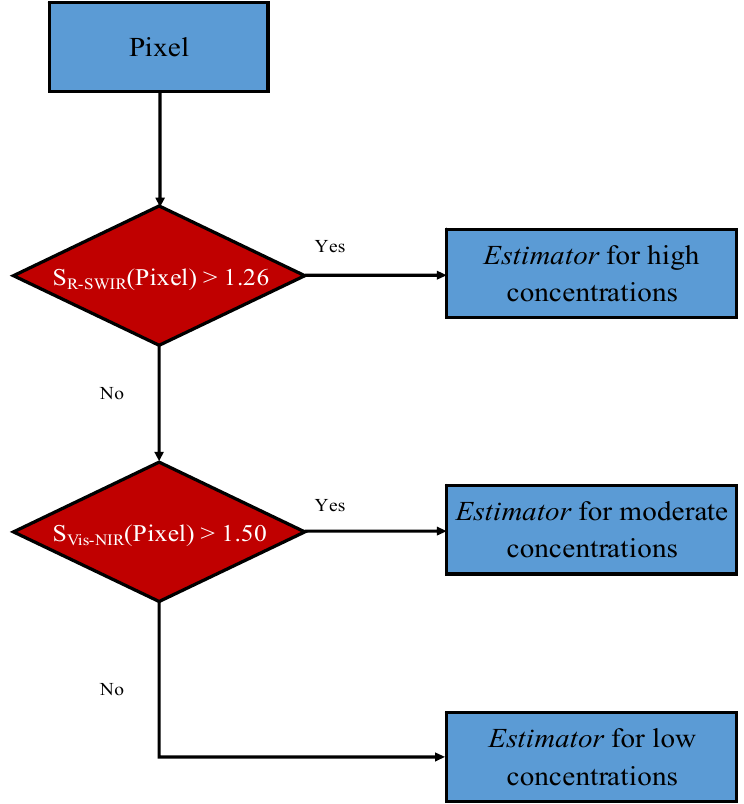
Figure 7. Thresholds values (×10 6 ) used to distinguish between the three chlorophyll-a blooming classes using the classification and regression tree method